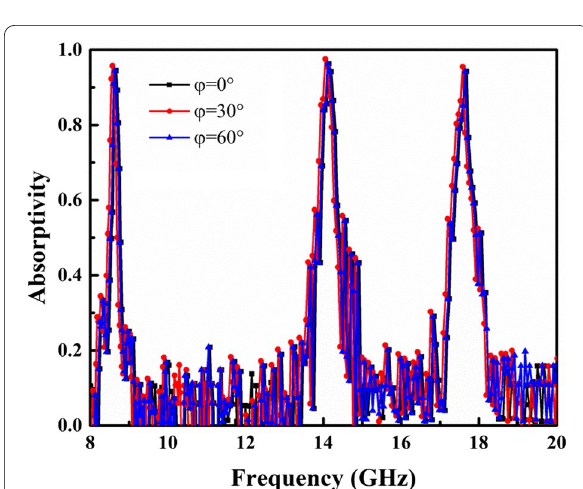
Fig. 9 Measured absorption for different polarization angles under normal incidence